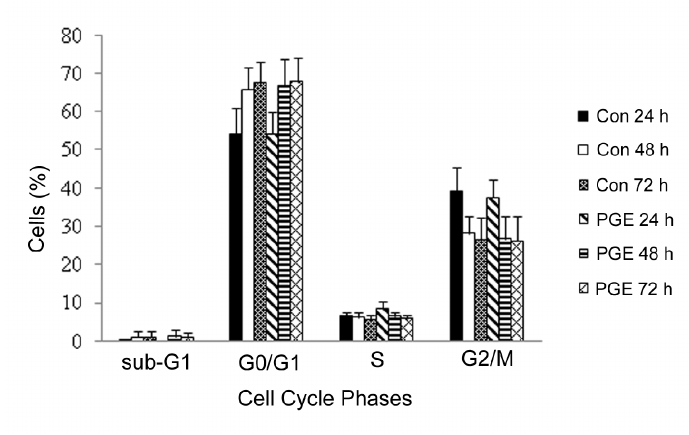
Figure 4. 3T3-L1 cells treated with Panax ginseng extract (PGE) for 24–72 h. Con refers to untreated control cells. Values are expressed as mean ±